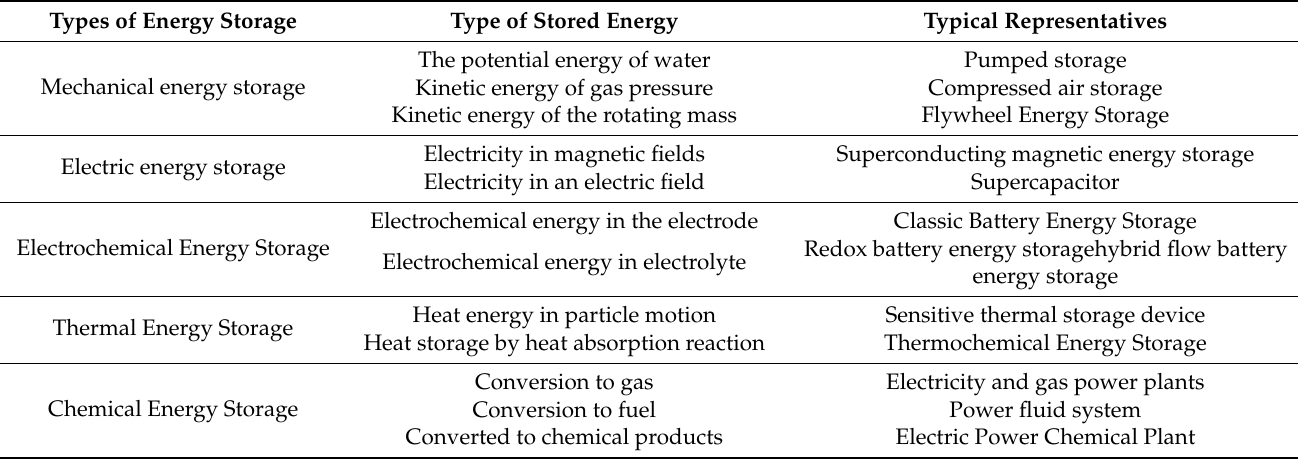
Table A2. Characteristics of Different Energy Storage Devices.